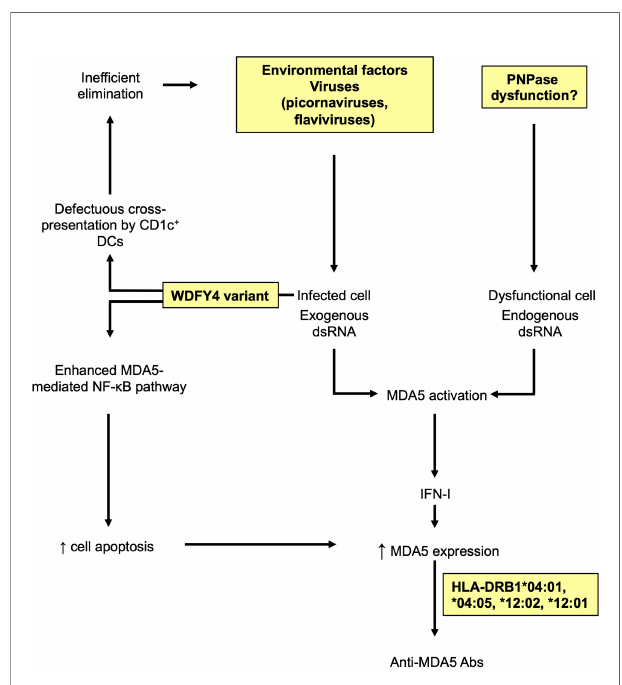
FIGURE 3 | Possible genetic and environmental factors involved in the anti- MDA5 dermatomyositis. Viral double stranded RNA (dsRNA) activates MDA5 in infected cells, leading to type I interferon (IFN-I) production and increased levels of MDA5. Altered WDFY4 impairs antigen cross-presentation by CD1c+ dendritic cells (DCs), favoring an inef fi cient elimination of infected cells and further activation of MDA5. In parallel, altered WDFY4 also enhances MDA5- mediated nuclear factor-kappa B (NF- k B) pathway leading to the apoptosis of infected cells, and the release of MDA5. Local dysfunctional mitochondrial polynucleotide phosphorylase (PNPase) could lead to intracellular accumulation of endogenous dsRNA, fueling uncontrolled activation and expression of MDA5. Abnormal accumulation of MDA5 may favor a loss of tolerance to MDA5 in an individual with proper genetic background, leading to anti-MDA5 antibodies